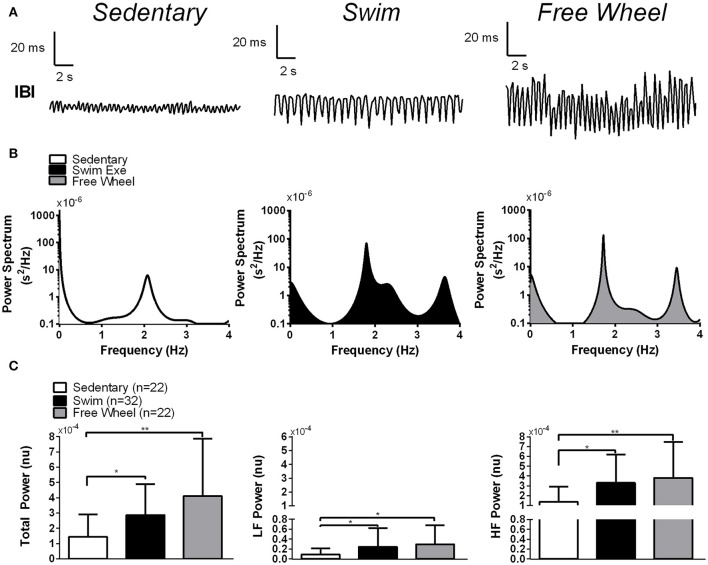
Effects of exercise and cardiac autonomic blockade on HRV. (A) Representative inter-beat-intervals (IBIs) as a function of time in a swim exercised, a free-wheel exercised and a sedentary mouse. The results clearly show increased fluctuations of the R-R intervals in exercise-trained mice compared to sedentary controls. (B) Typical examples of spectral power of the HRV (generated by Fast Fourier transforming the R-R intervals) (1996) as a function of frequency for a swim exercised mouse, a free-wheel exercised mouse and a sedentary mouse. Notice the clear increase in the amplitude of the spectral power in the exercised mice compared to the sedentary mouse at virtually all frequencies. (C) Integration of the spectral density of the HRV from 0.1 to 5.0 Hz (Total Power, left panel), from 0.1 to 1.0 Hz (Low Frequency Power, middle panel) and from 1.0 to 5.0 Hz (High Frequency Power, right panel) in sedentary, swim exercised and free-wheel exercised mice, corrected for HR (by multiplying by HR2, see section Methods). In our analysis, three outliers were identified using Grubb's test (n = 1 for the swim group) and (n = 2 for free-wheel group) which had HRV well beyond the upper limit of our data distribution. Power spectral data is presented as mean±SD. *P < 0.05;
**P < 0.01.